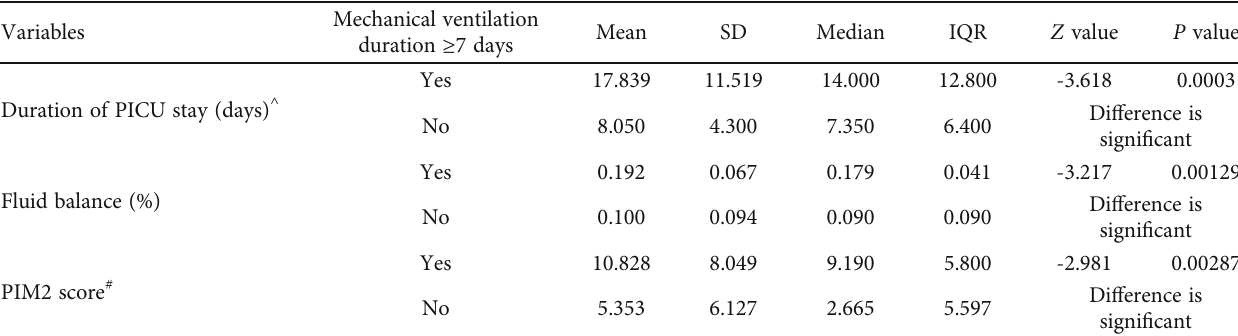
Table 5: Comparison of various variables between cases with and without mechanical ventilation duration ≥ 7 days .